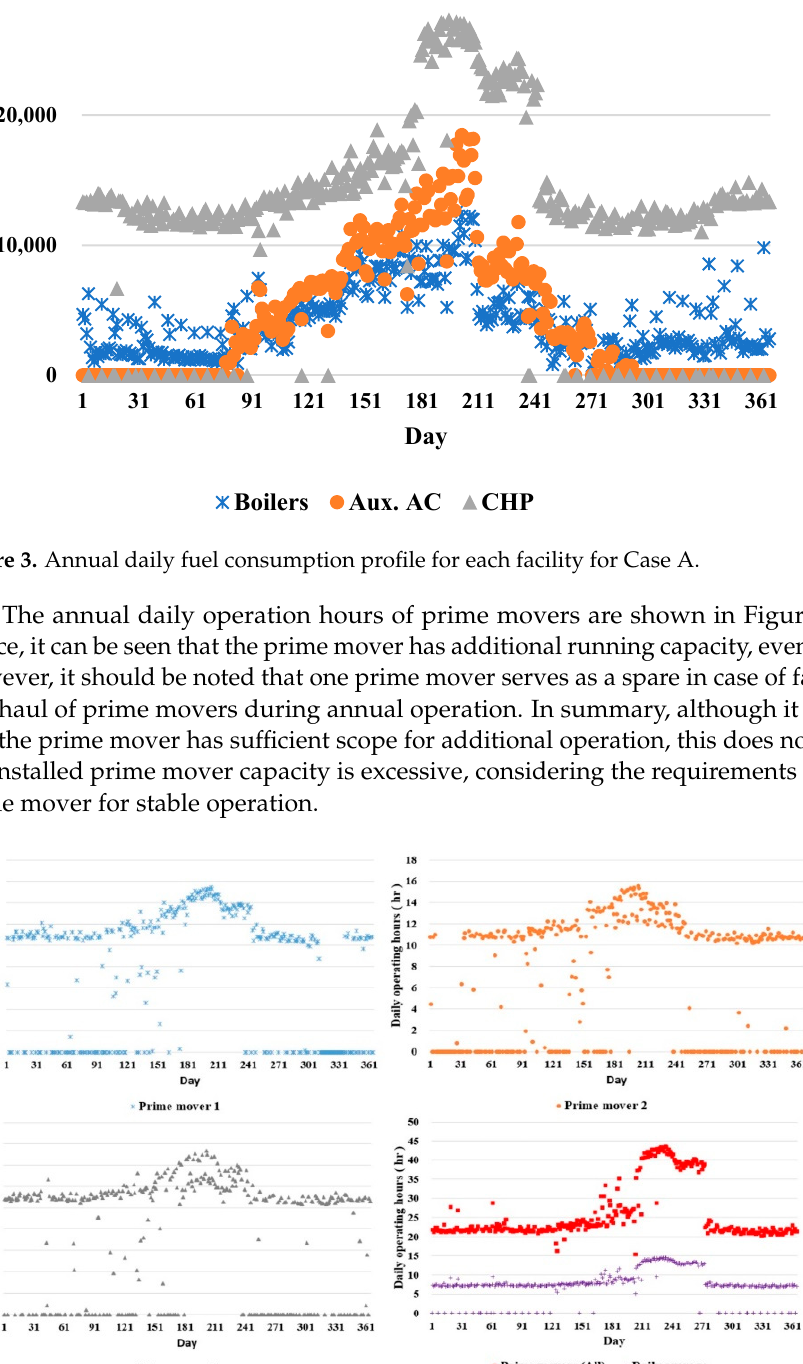
Figure 3. Annual daily fuel consumption profile for each facility for Case A.